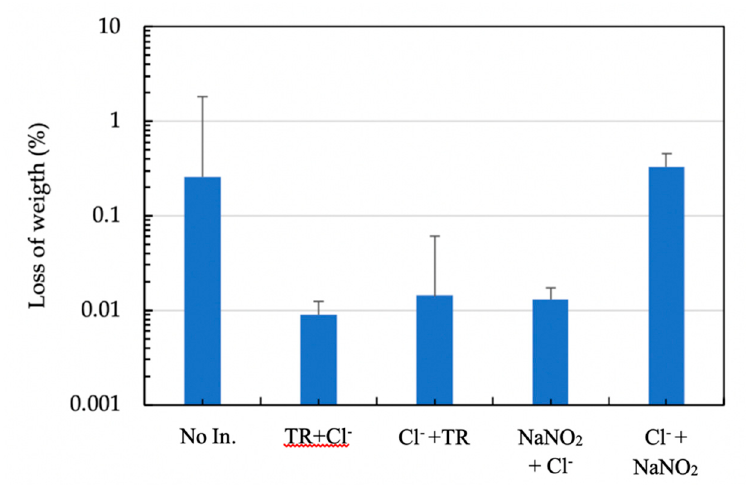
Figure 1. Results of the loss of weight tests in Ca(OH) 2 solution at pH 12.7 and 0.28 M of tartrate ions and nitrite.